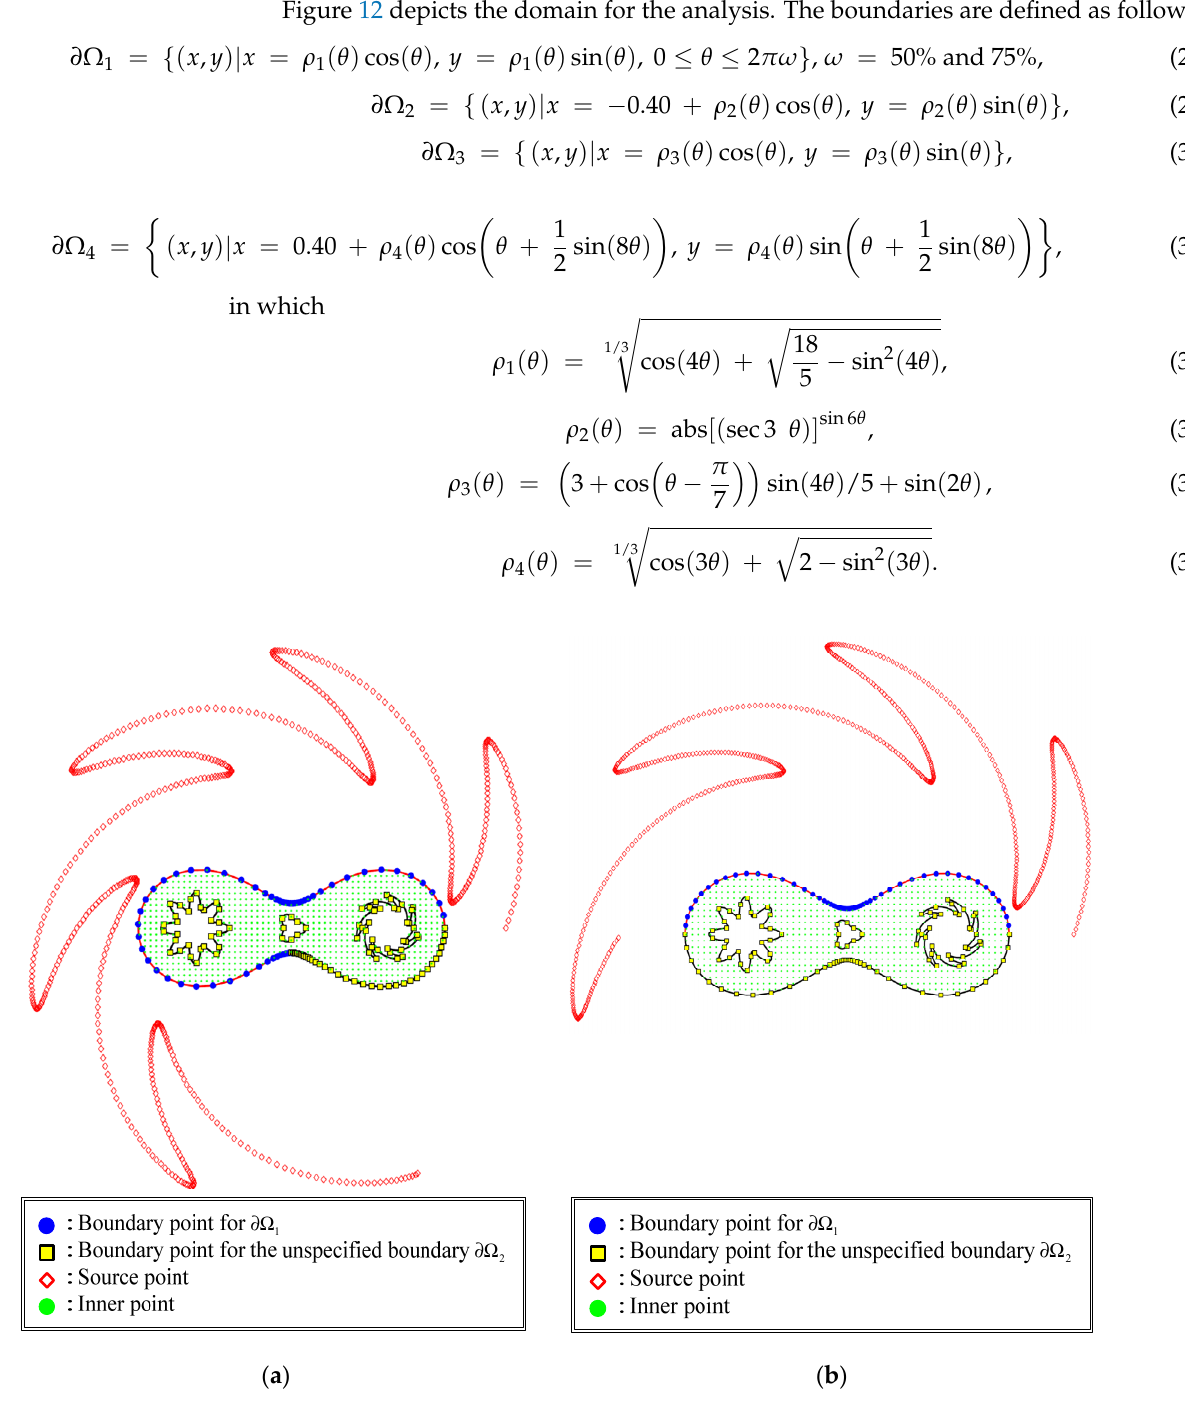
( b ) Figure 13. Error versus the terms of the PPs and dilation parameter: ( a ) Error versus the terms of the PPs for case A. ( b ) Error versus the dilation parameter for case B.